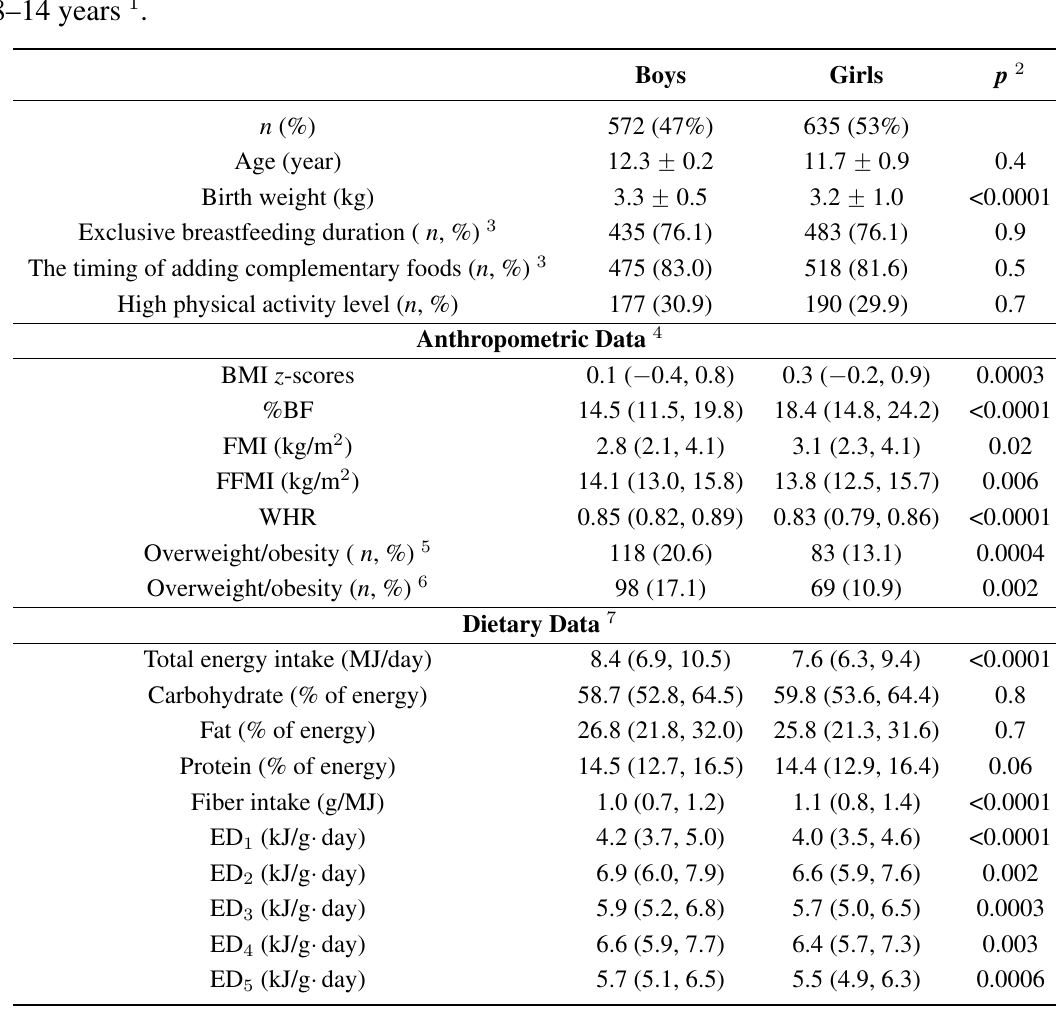
Table 1. Early life, anthropometric, dietary and family characteristics of children aged 8–14 years 1